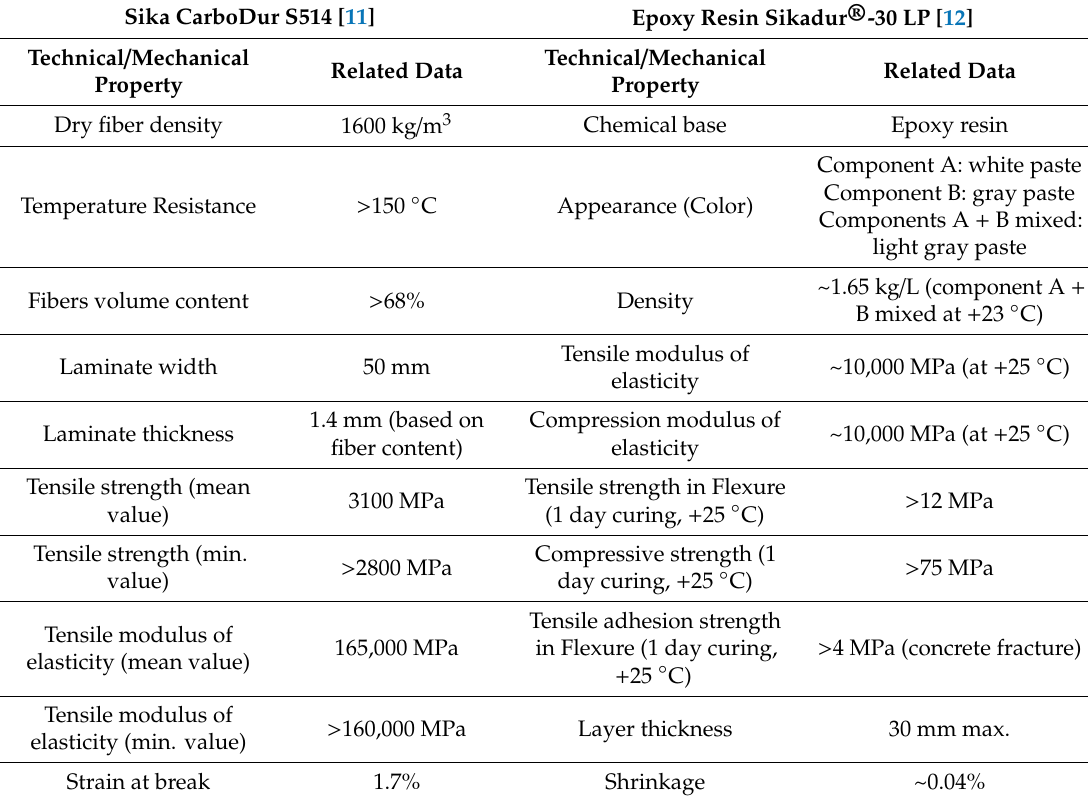
Table 3. Technical and mechanical properties of carbon fiber-reinforced polymer (CFRP)